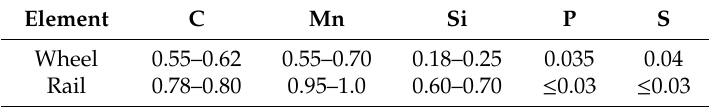
Figure 1. Sampling position ( a ) and scheme of geometrical contact ( b ) for the wheel and rail specimens.